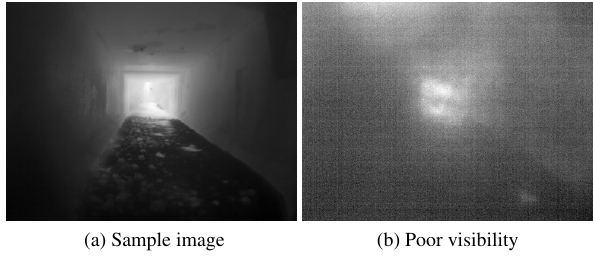
Figure 2. View into a clinker